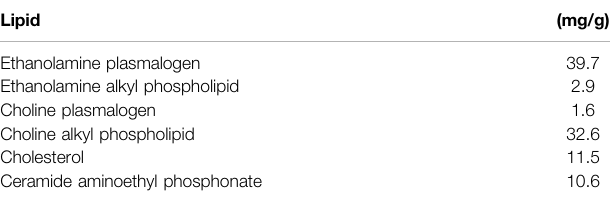
TABLE 1 | Lipid composition of puri fi ed ether phospholipid from scallop.